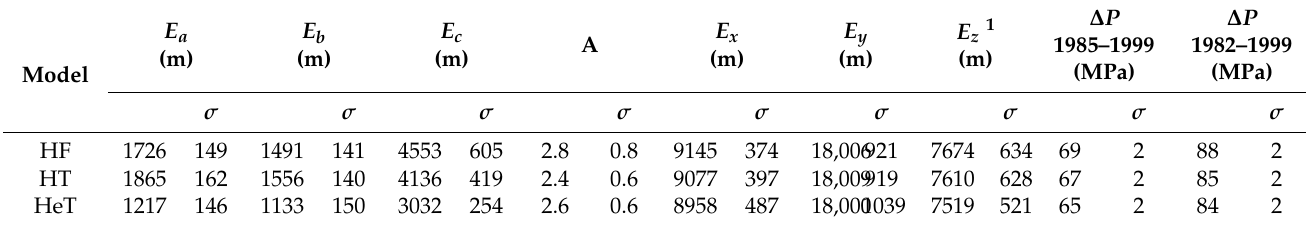
Table 3. Best fit source parameters, and associated uncertainties estimates σ , obtained from the joint inversion of EDM + Leveling data for the period 1985–1999 and optimal overpressure obtained from the inversion of leveling data for the period 1982–1999. HF: homogeneous flat crust; HT: homogeneous crust with topography; HeT: heterogeneous crust with topography.